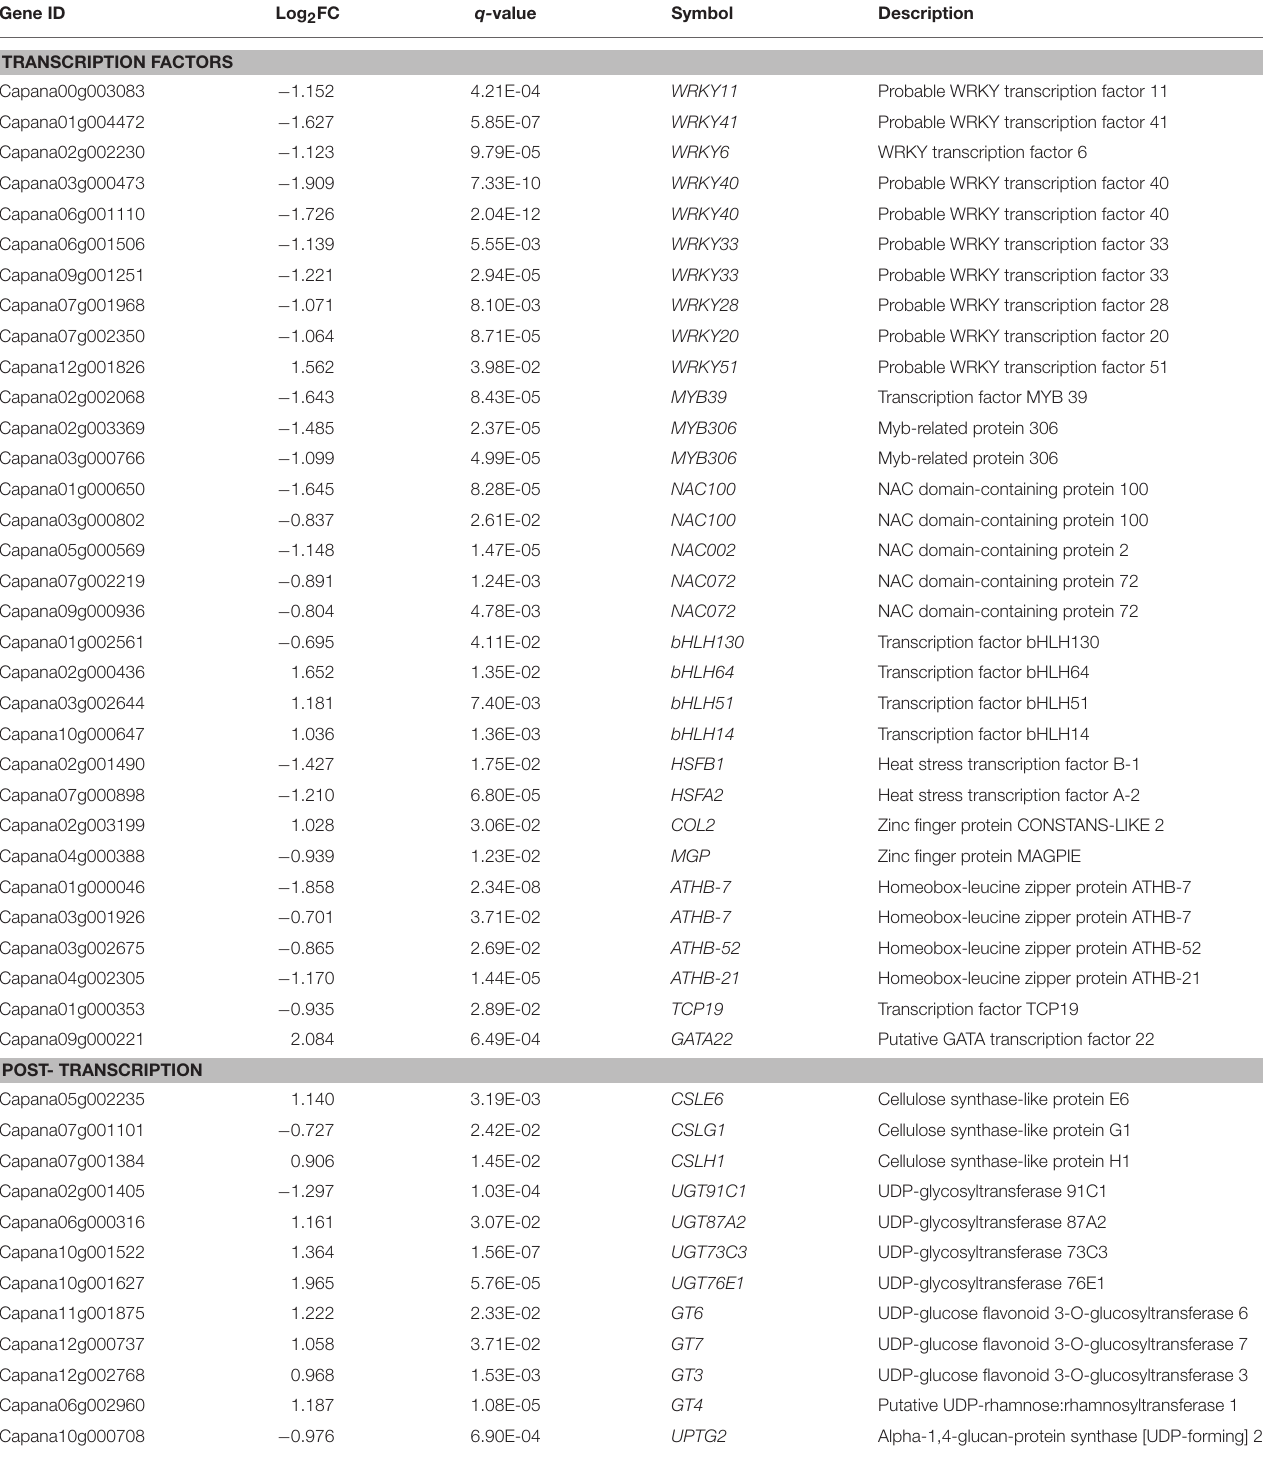
TABLE 7 | Transcription factors and post-transcription related genes expression in pepper leaves as influenced by chilling alone or in combination EBR